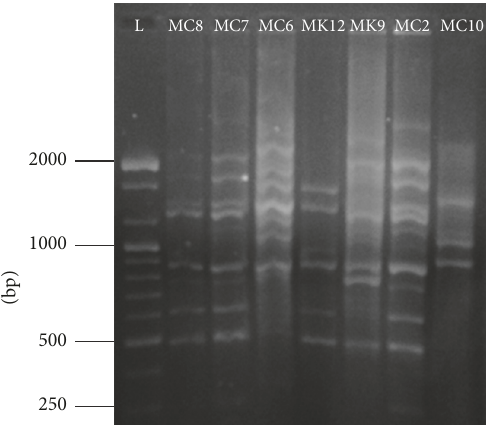
Figure 4: Agarose gel electrophoresis of DNA fingerprint patterns of rhizobia isolates generated in the reactions with BOXA1R primer.